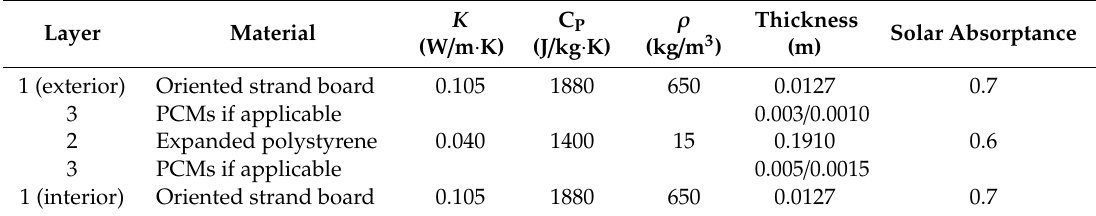
Figure 4. Schematic of the typical external wall (with PCM layer) used in the simulations. Table 3. Building materials for partition wall construction.